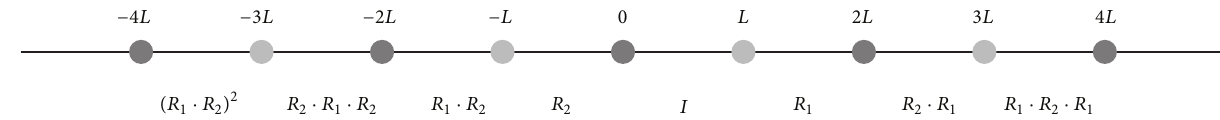
of the infinite dihedral group. 𝑖